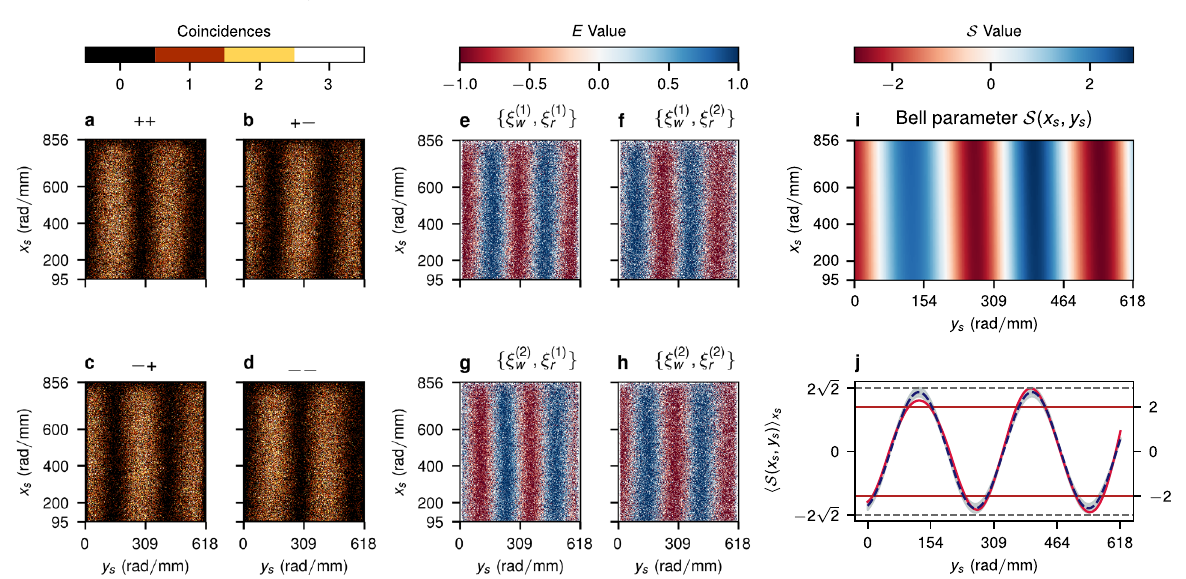
Fig. 2 Wavevector-resolved Bell-state measurement between write-out and read-out photons. a – d Coincidences between ( s r , s w ) = {( + , + ), ( + , − ), ( − , + ), ( − , − )} ports, respectively, with a single pair of Alice and Bob bases f ξ ð 2 Þ ; ξ ð 2 Þ ; ξ ð 2 Þ f ξ ð 1 Þ g and f ξ ð 1 Þ g bases. Each expected value is a linear combination of coincidences between ± ports. i Bell parameter S ð x s ; y s Þ retrieved by fi tting a w w r r sine function (with x s and y s spatial frequencies) to the expected value for each combination of bases and taking the Bell linear combination of the results. j Bell parameter averaged over x s (red curve) along fi tted sine (blue dashed curve) with amplitude 2.60± 0.19 indicating CHSH violation by more than three standard deviations σ . Subsequent shadings correspond to σ and 2 σ . Solid lines indicate CHSH inequality violation